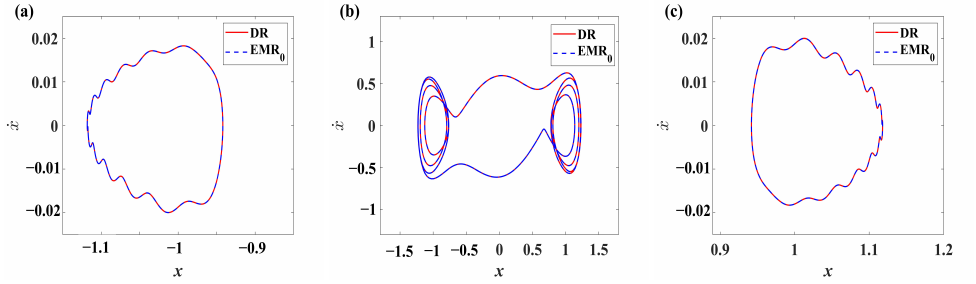
Figure 3. The phase portraits of DR and EMR 0 . ( a , b , c ) are obtained under the initial conditions [ x , ˙ x , v ] = [ − 1.0, − 1.0,1.0 ] , [ x , ˙ x , v ] = [ 0.0, − 0.5,1.0 ] , [ x , ˙ x , v ] = [ − 0.5,1.0,1.0 ]